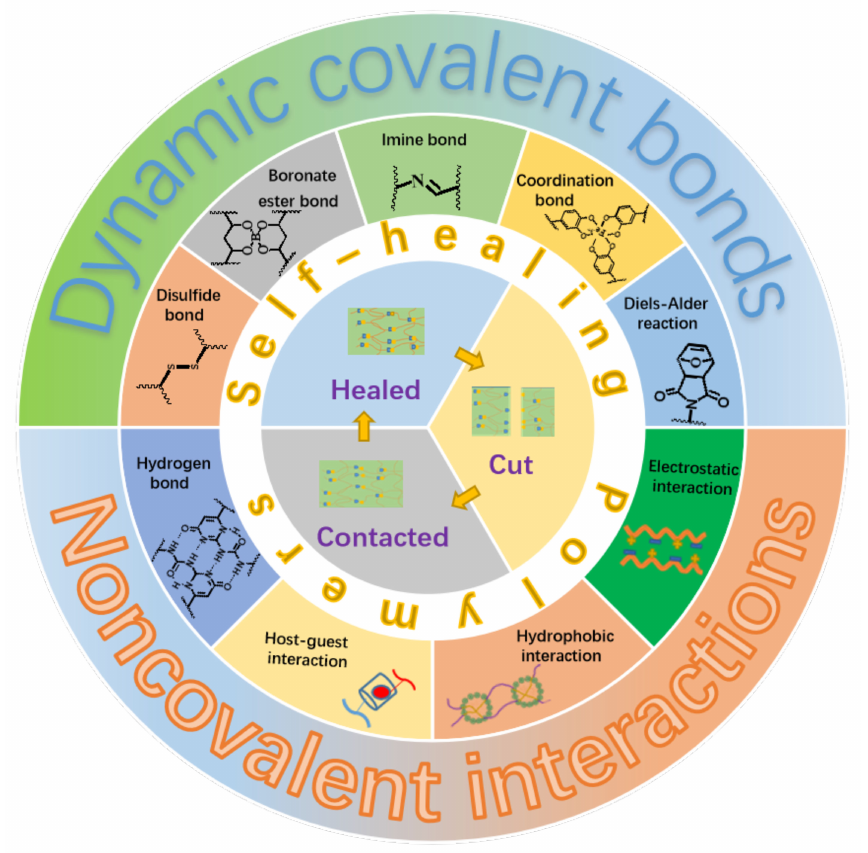
Figure 1. Illustration of self-healing elastomers based on different dynamic covalent bonds or/and non-covalent